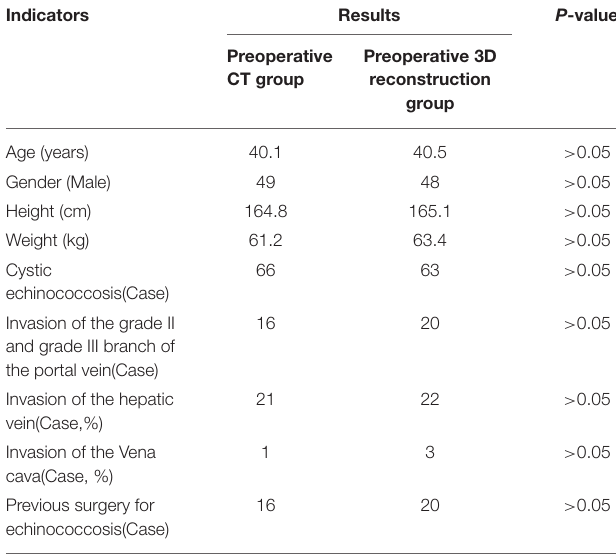
TABLE 1 | The general characteristics of the patients between the preoperative CT group and the preoperative three-dimensional reconstruction group before